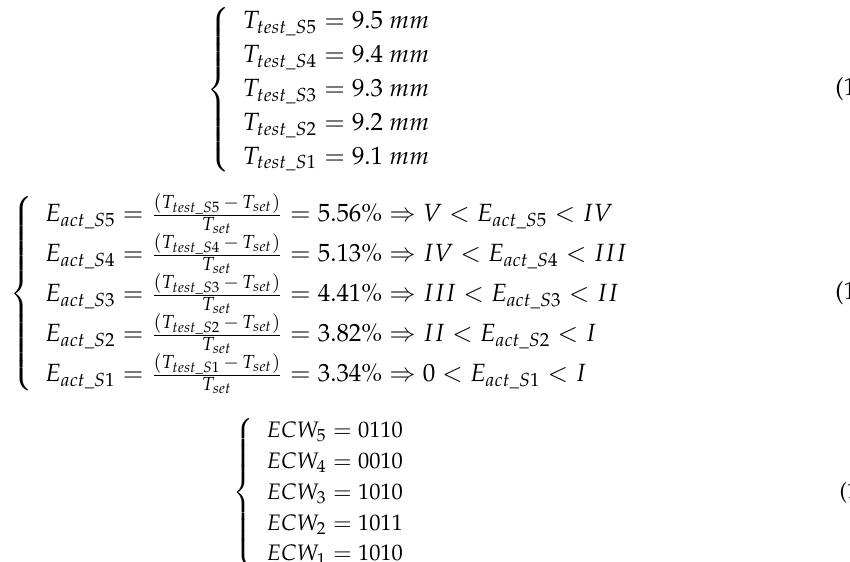
Figure 9. Thickness of the viscoelastic load and output of the cylinder.